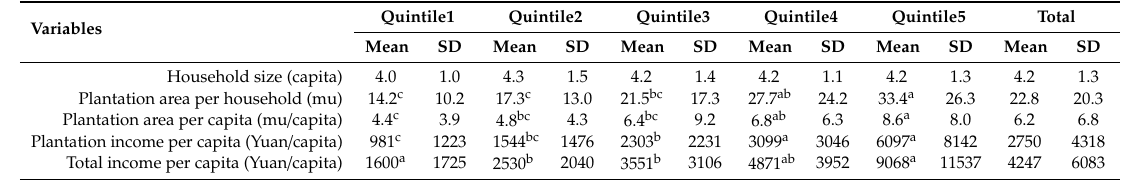
Table 4. Land and income characteristics by household income classes within the Plantation group. Variables